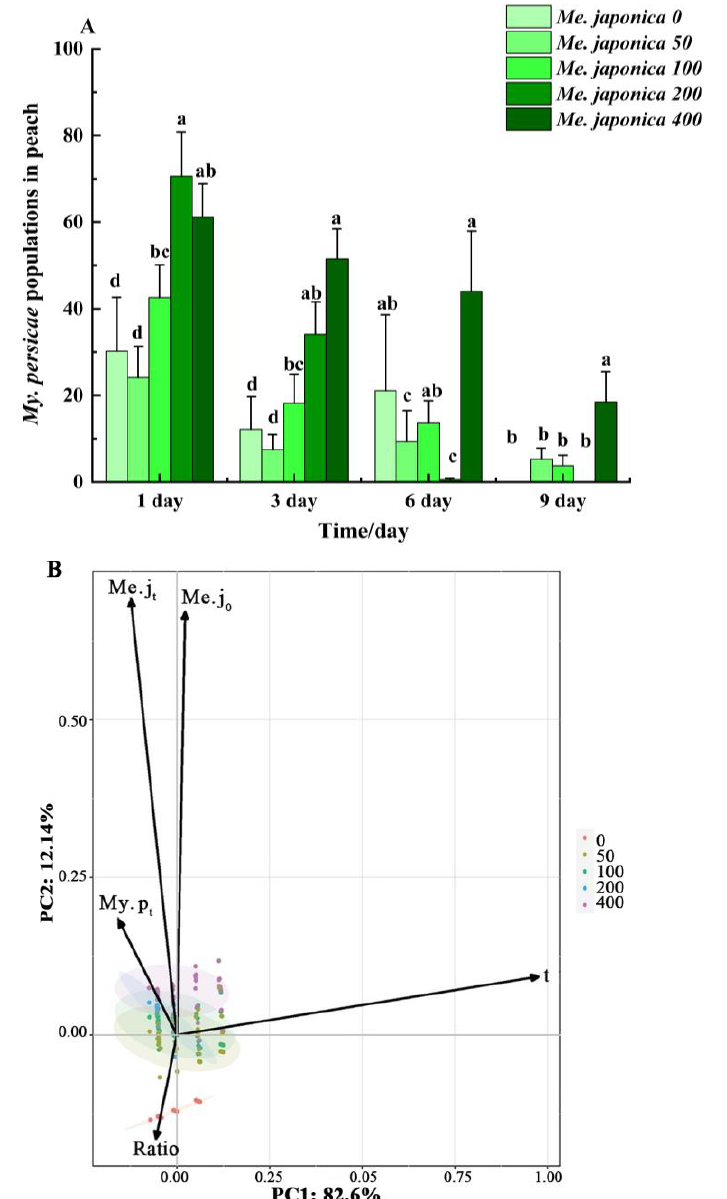
Figure 6. ( A ) Myzus persicae population in presence of Megoura japonica different initial numbers at different times (initial numbers of My. persicae : 100 aphids/plant). ( B ) Principal component analysis performed on the experimental day (t), initial numbers of Me. japonica (Me. j 0 ), relative numbers of Me. japonica (Me. j t ), relative numbers of My. persicae (My. p t ), and the ratio of My. persicae/Me. japonica (My. p t /Me. j t ). Different lowercase letters within the same sampling date indicate significant differences ( p < 0.05).